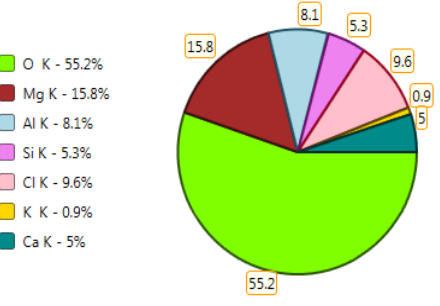
Figure 23. X-ray microanalysis (EDS) in point 1 from Figure 22.